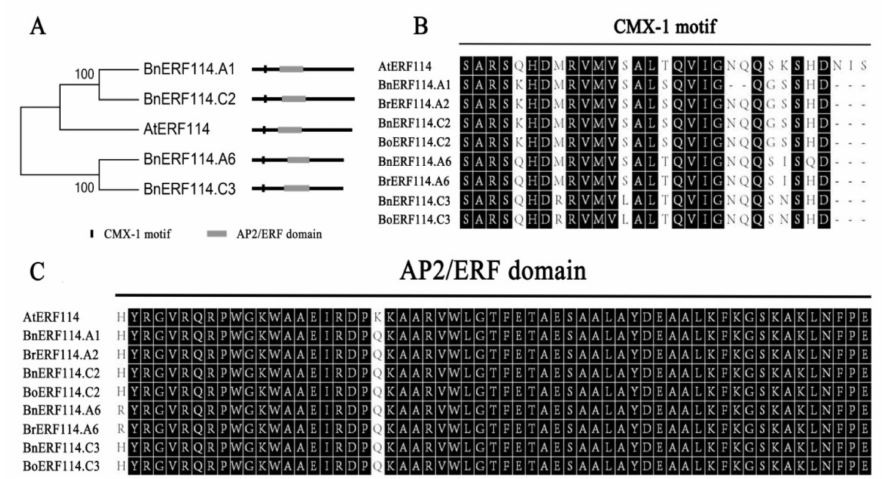
Figure 1. The conserved structures of ERF114 proteins. ( A ) phylogenetic analysis and the structure diagrams of ERF114 proteins in Brassica napus and Arabidopsis . ( B ) alignment of the CMX-1 motif of ERF114 in B. napus , B. rapa , and B. oleracea. ( C ) alignment of the conserved AP2/ERF domain of ERF114 in B. napus , B. rapa , and B. oleracea . In ( B , C ), amino acids with black background indicate conserved amino acid residues across